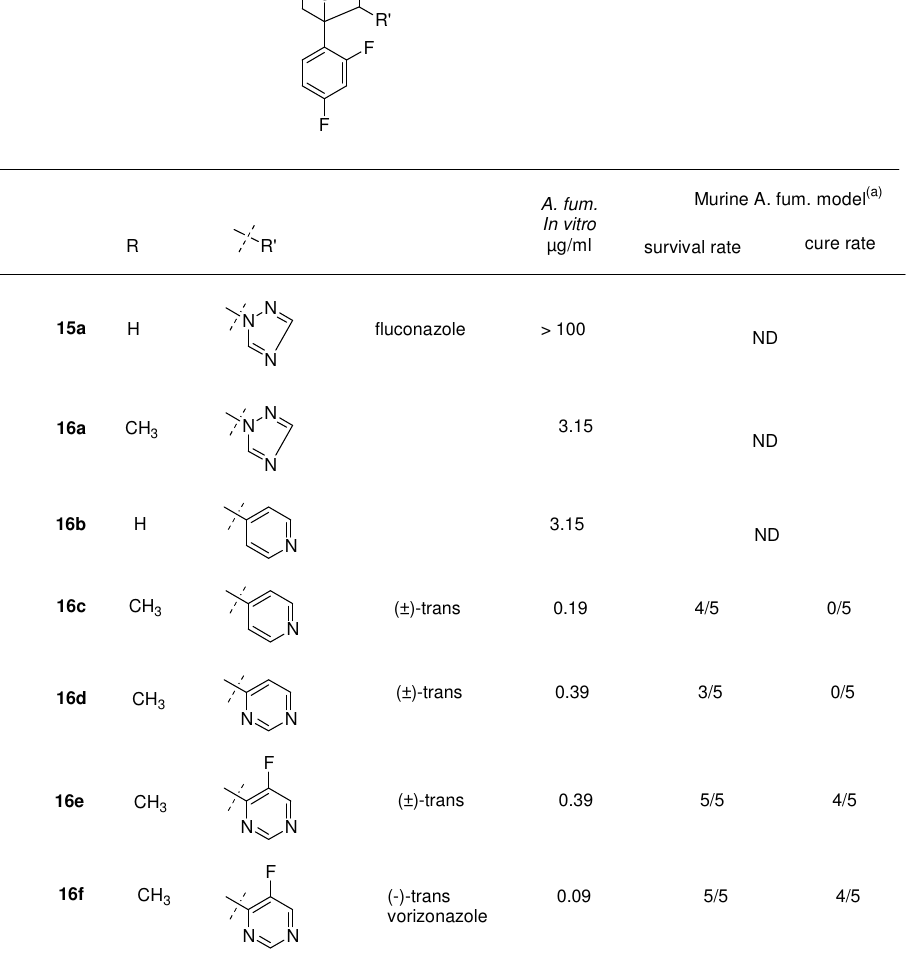
Table 6. In vitro and in vivo activity of fluconazole and analogues against A . fumigatus.